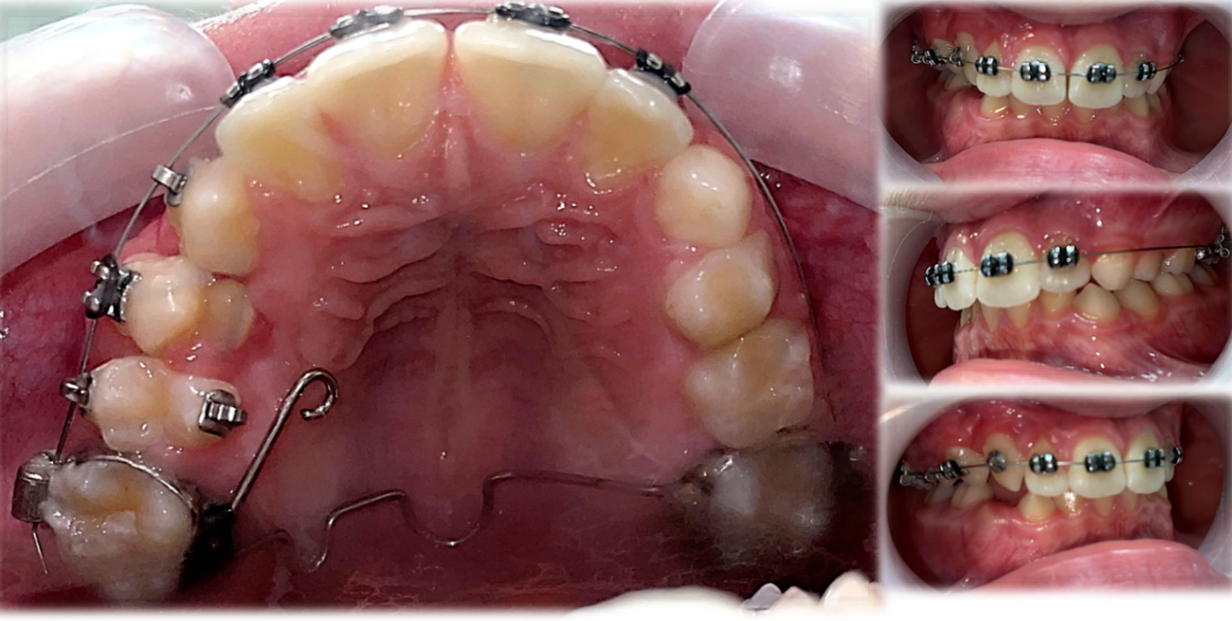
Figure 13. Treatment